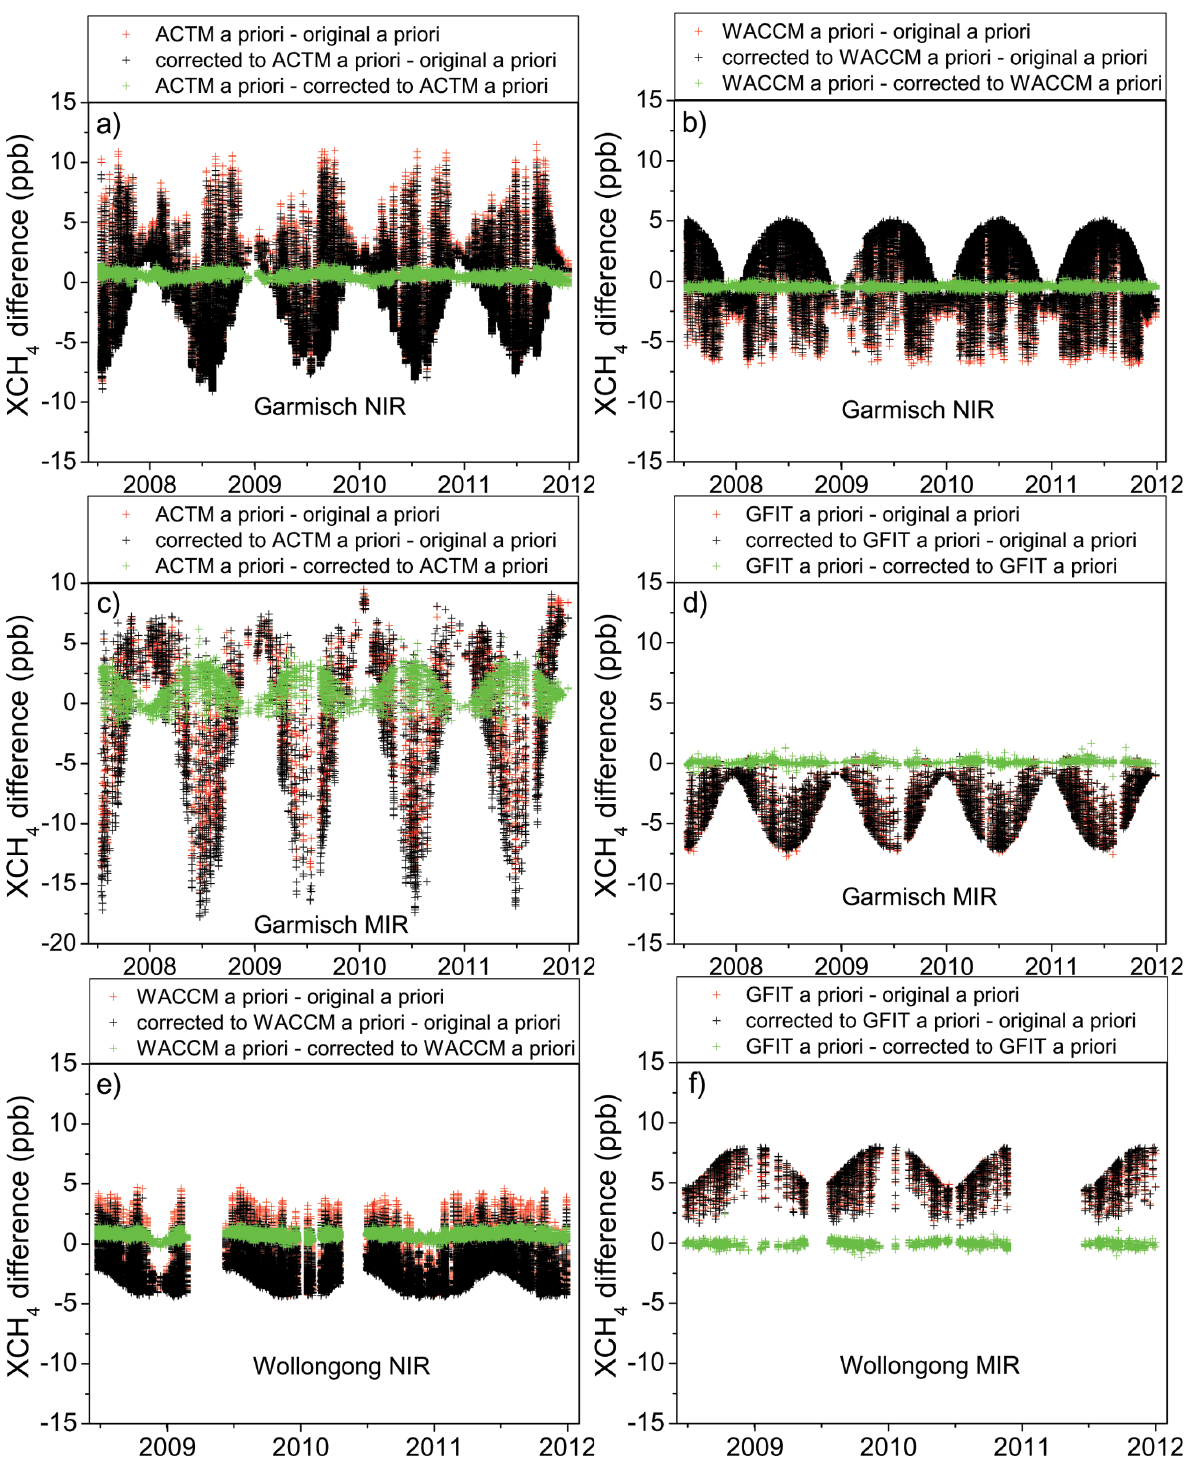
Fig. A1. Investigation of the validity of the linear approximation within Eq. (1). (a) Red: XCH 4 from Garmisch NIR measurements retrieved with 3-hourly ACTM profiles minus retrievals using the original (GFIT) prior. Black: same as red but using Eq. (1) for a posteriori exchange of the a priori profile. Green: difference between red and black – deviations from zero are due to non-linearity of the retrieval. Data basis is retrievals from individual NIR and MIR spectra constructed from same-day NIR–MIR coincidences. (b) Same as (a) but for Garmisch NIR retrievals using the WACCM a priori profile (i.e., the prior of the MIR retrievals), (c) Garmisch MIR retrievals using the 3-hourly ACTM profiles, (d) Garmisch MIR retrievals using the GFIT a priori, (e) Wollongong NIR retrievals using the WACCM a priori, and (f) Wollongong MIR retrievals using the GFIT a